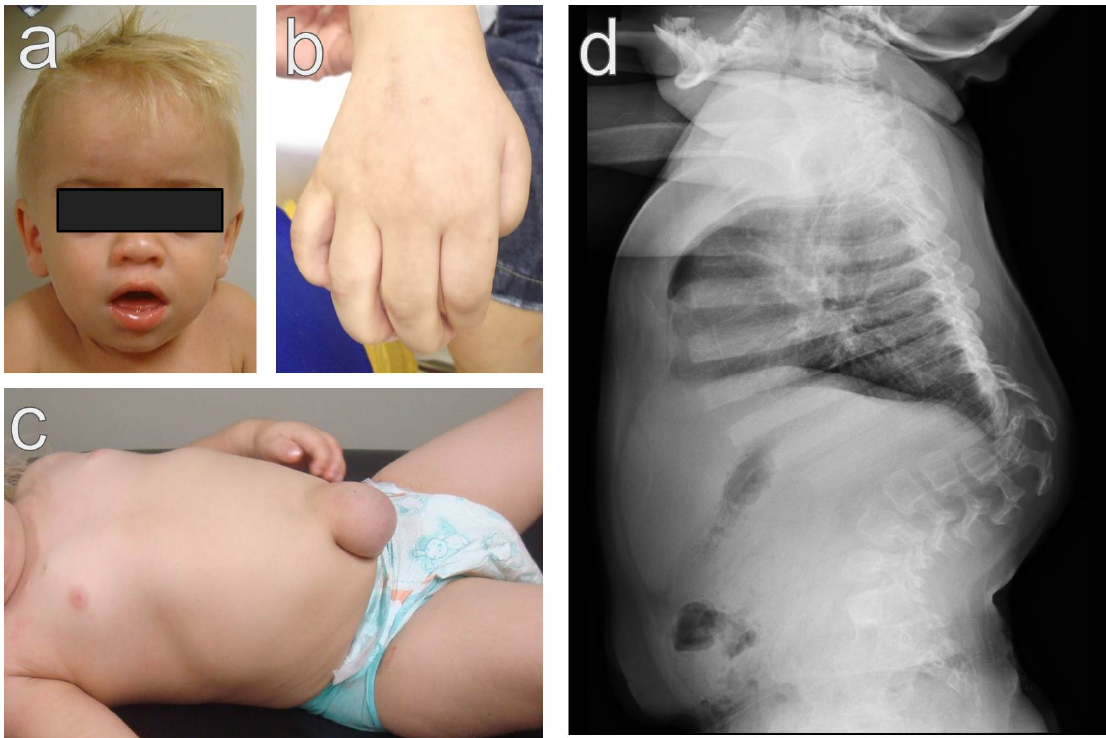
Figure 1. Hurler syndrome features. ( a ). Coarse facial features. Note the large forehead, short neck, broad nasal tip, coarse facial features, and corneal clouding. ( b ). Claw hands due to camptodactyly of the fingers. ( c ). umbilical hernia. ( d ). lateral view of the spine. Note the thoracolumbar kyphosis and the broad ribs. Informed consent was obtained for image use.